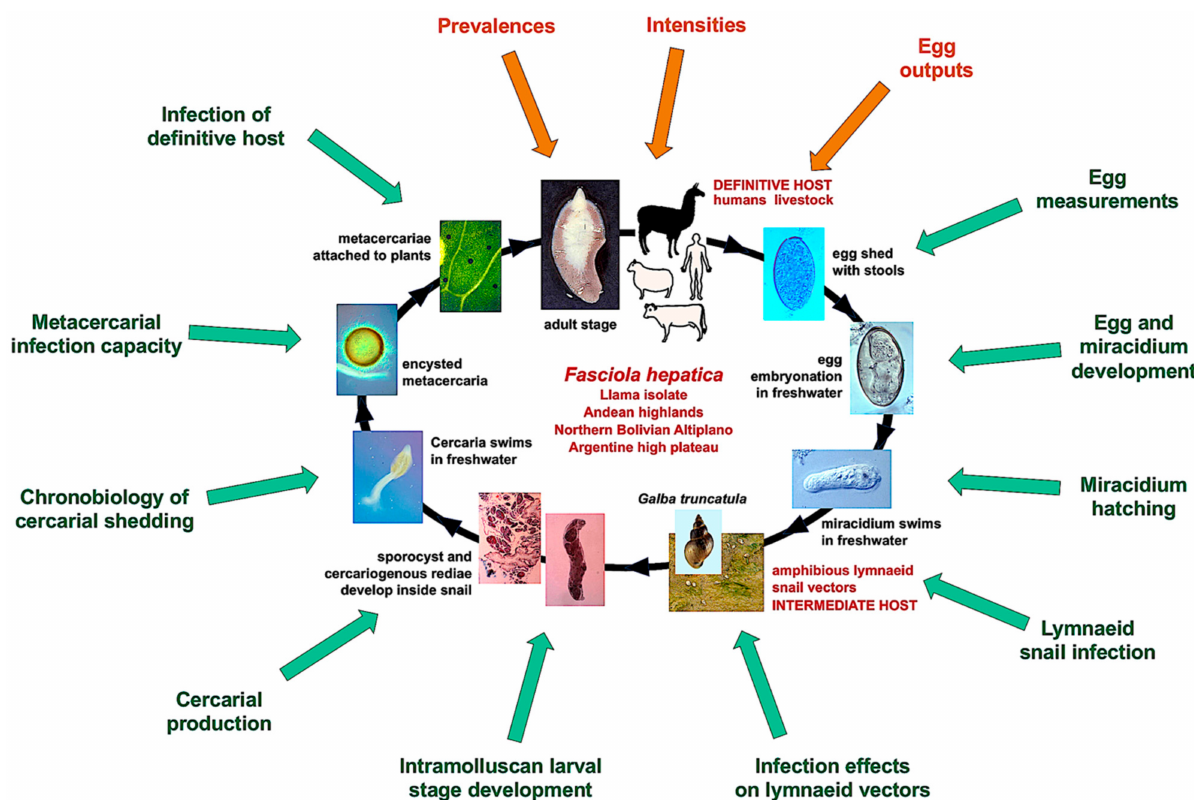
Figure 1. Life cycle of Fasciola hepatica including detailed development phases: Aspects assessed for the characterization of the transmission capacity and epidemiological role of the llama from Andean highlands by comparing with sheep and cattle isolates from the Northern Bolivian Altiplano human hyperendemic area. Green arrows: experimental assessments; brown arrows: field assessments. Schematic drawing by S.